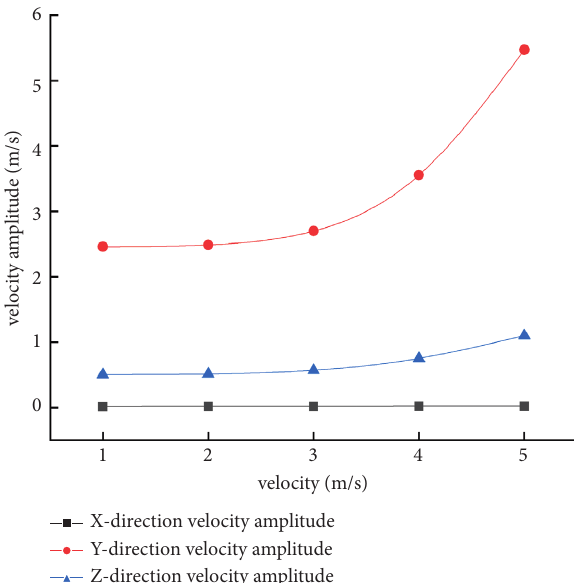
Figure 11: Variation curve of velocity amplitude in different di- rections with natural gas velocity.